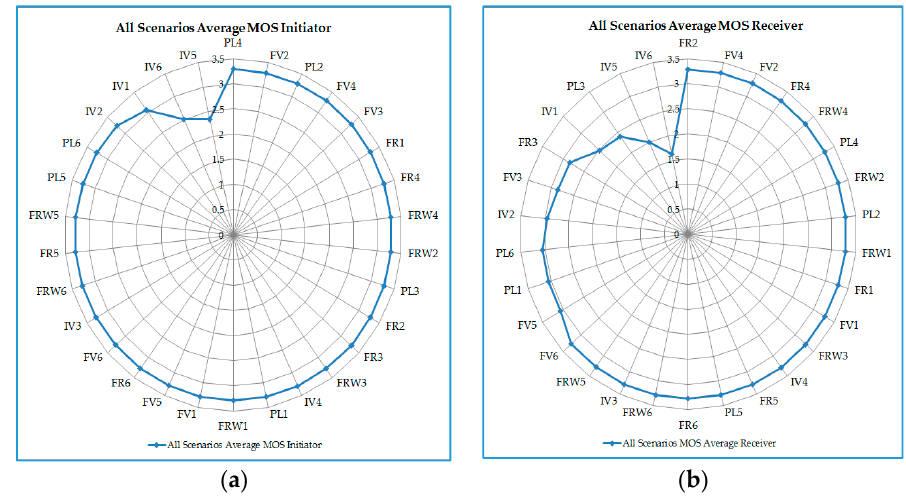
Figure 14. Platoon MOS values for VoIP initiators and receivers: ( a ) VoIP initiators; ( b ) VoIP receivers. Information 2017 , 8 , 88